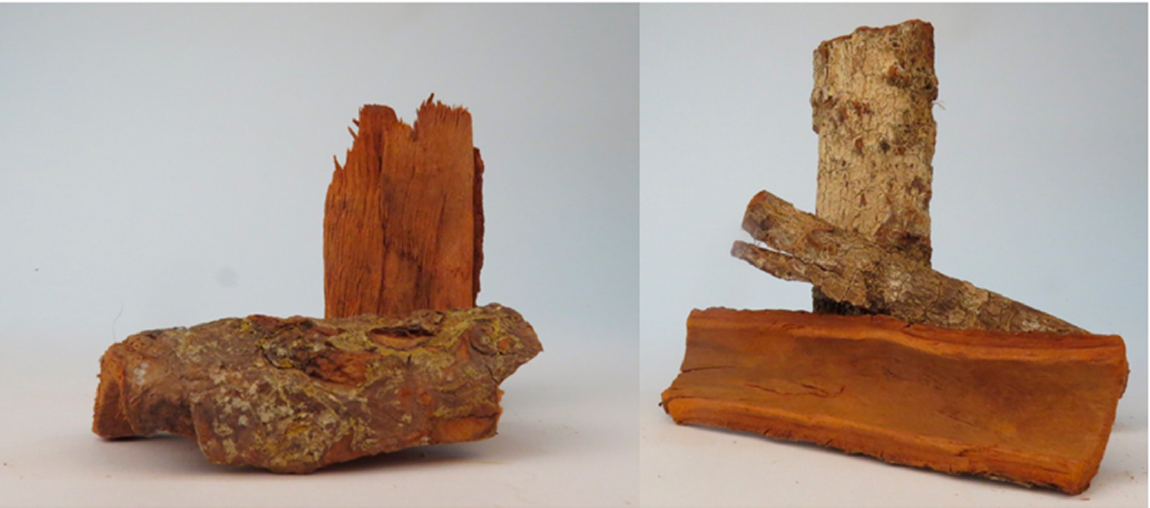
Figure 5. Examples of Cinchona barks stored at The Museum of Natural Medicine & The Pharmacognostic Collection (University of Copenhagen).